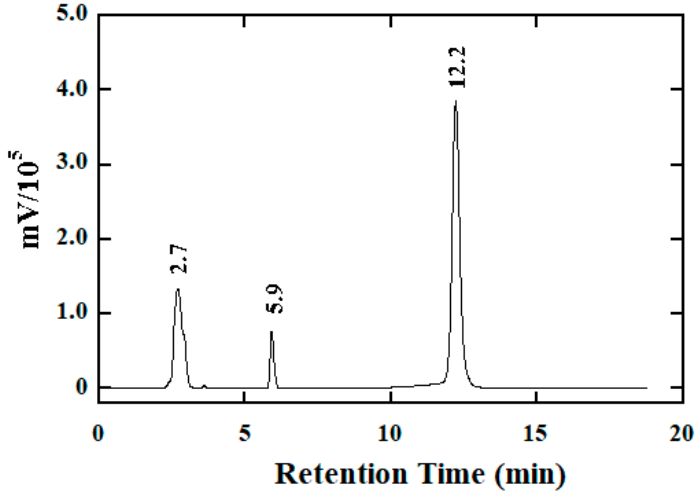
Figure 5. HPLC chromatogram obtained for a reaction mixture containing 2.5 mM [IrCl 6 ] 2 − and 2.5 mM BH in a phosphate bu ff er of pH 6.34 after a reaction time of 10 min. Peak assignments: Peak at 2.7 min for [IrCl 6 ] 3 − ; Peak at 5.9 min for benzoic acid; Peak at 12.2 min for BH. Chromatographic conditions: a solvent mixture of H 2 O:MeOH = 4:1 ( v / v ) was the mobile phase; the UV detector was set at 261 nm; the flow rate was set at 1.0 mL /